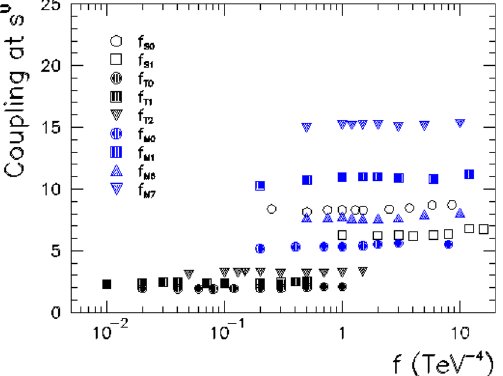
√ Fig. 6 Maximum value C max of the coupling constants related to individual dimension-8 operators, calculated at the energy where the unitarity limit is reached, as a function of the relevant f